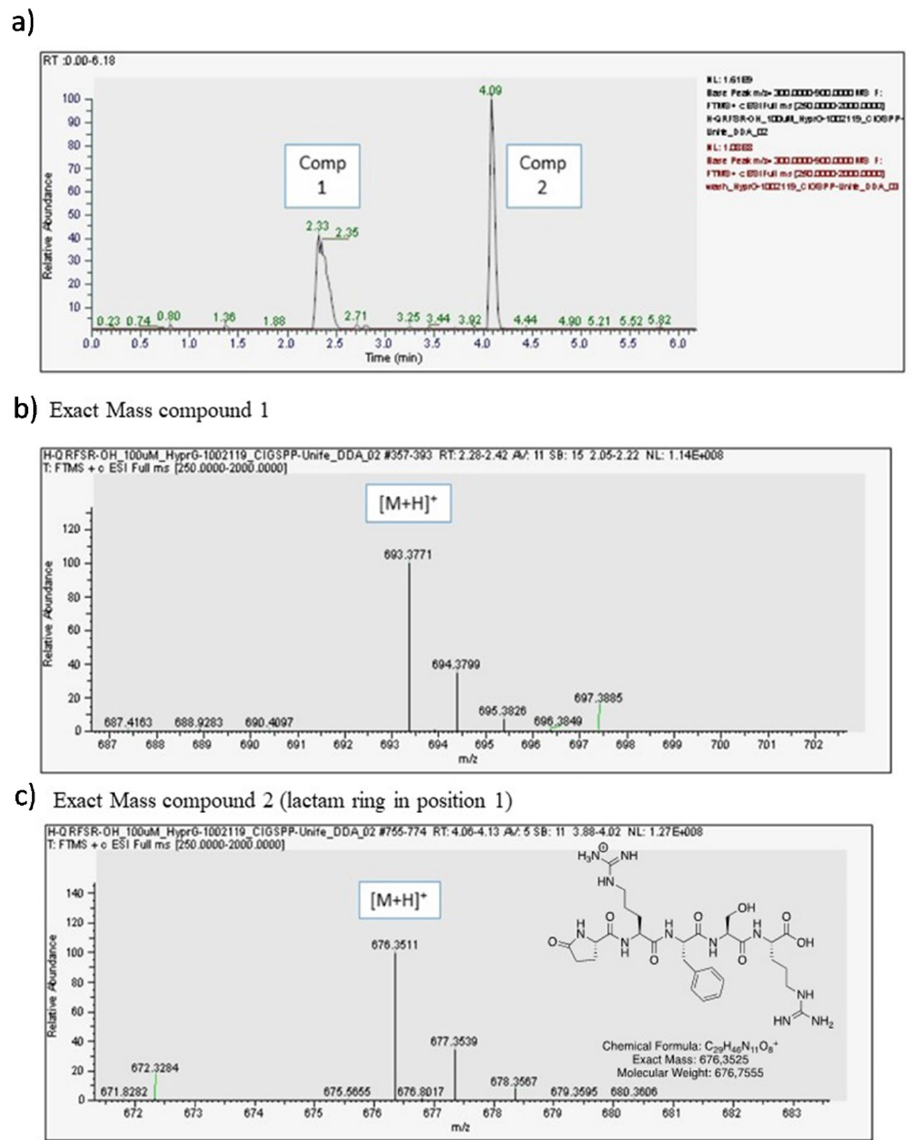
Figure 4. Opiorphin detection in GlicoPro. ( a ) High-performance liquid chromatography chromatogram of GlicoPro; ( b ) exact mass of compound 1, identified as opiorphin; ( c ) exact mass of compound 2, identified as lactame derivative of opiorphin in position 1.